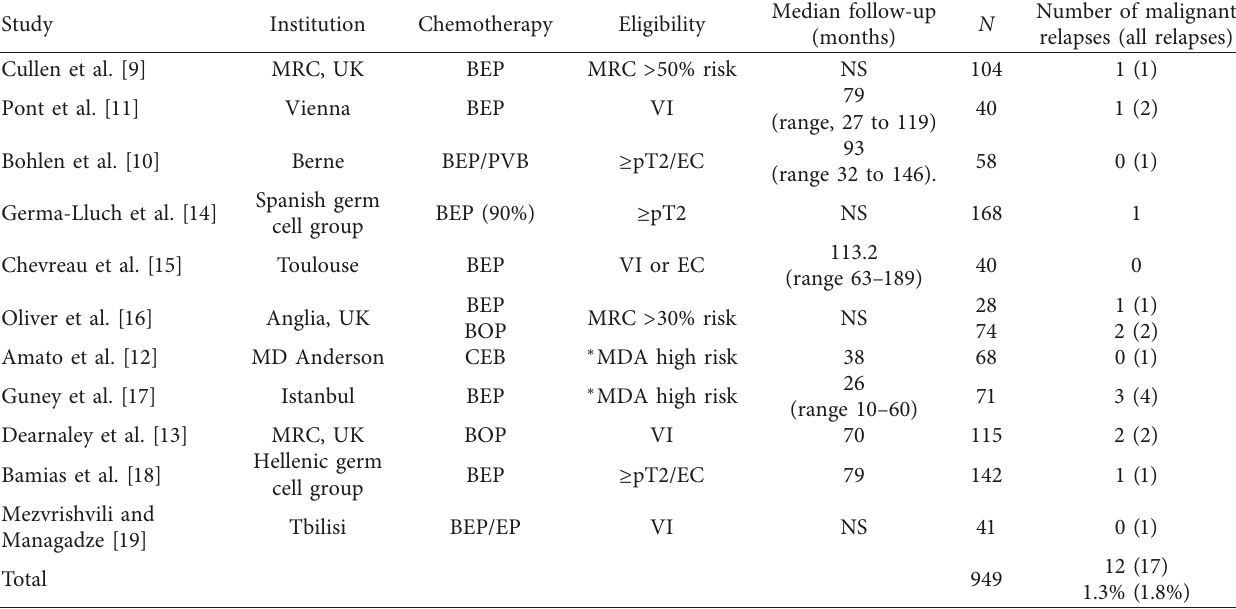
Table 2: Studies of 2 cycles of adjuvant chemotherapy in testicular nonseminomatous germ cell tumours.